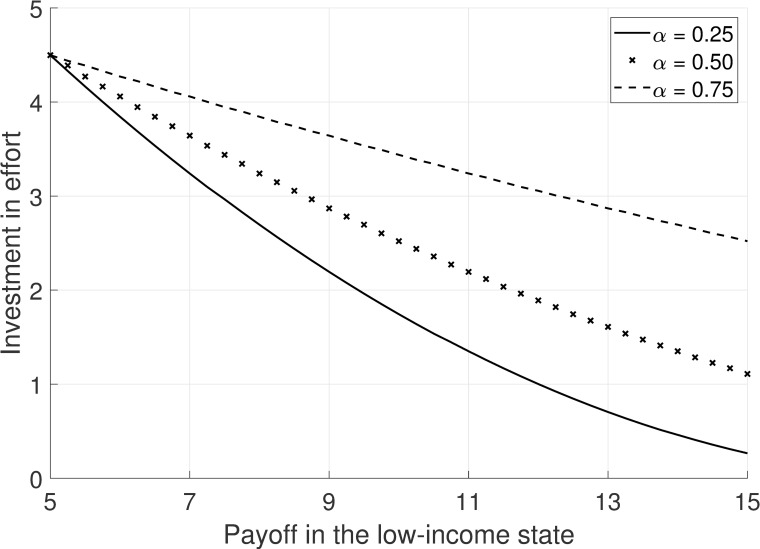
Effort provision as a function of financial support for different intensities of social preferences α.